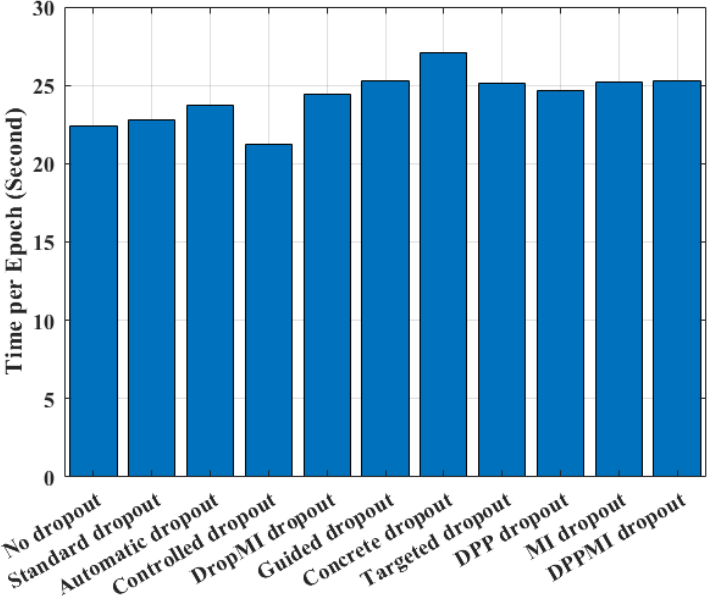
Figure 9. Comparison of the elapsed time per epoch for different